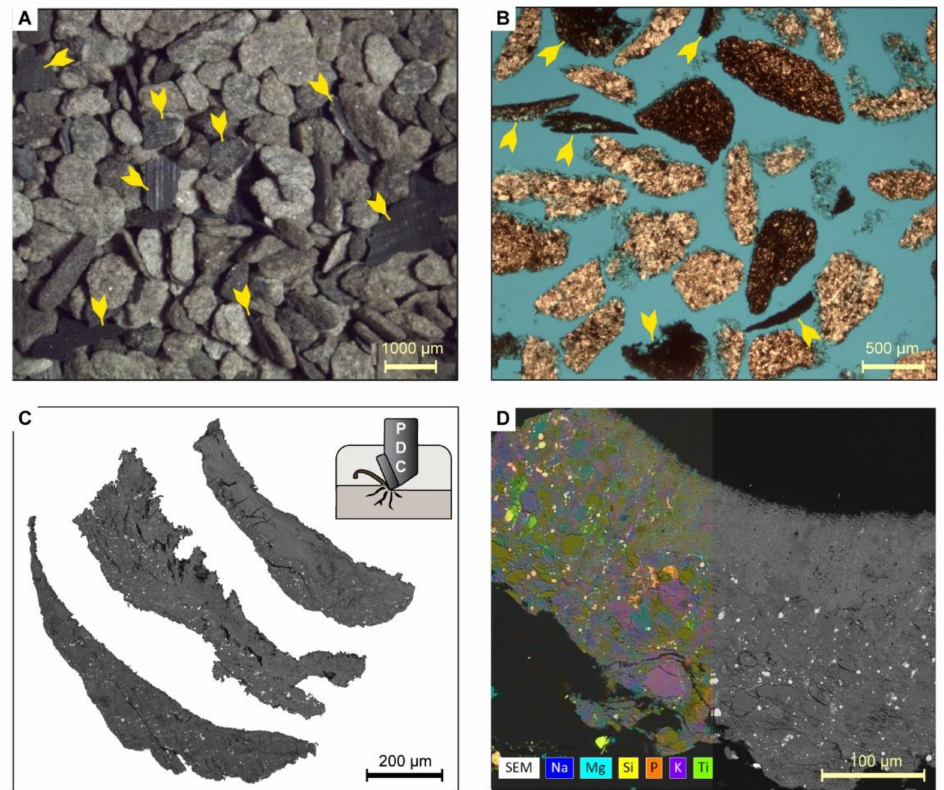
Figure 9. Examples of drill cutting chips exhibiting drill bit metamorphism (DBM) (yellow arrows) seen under the stereo ( A ), petrographic ( B ), and electron ( C , D ) microscopes. ( D ) SEM-BS-EDX pho- tomicrograph showing the unaltered minerals of a DBM rock chip; the provided example represents an organic-rich